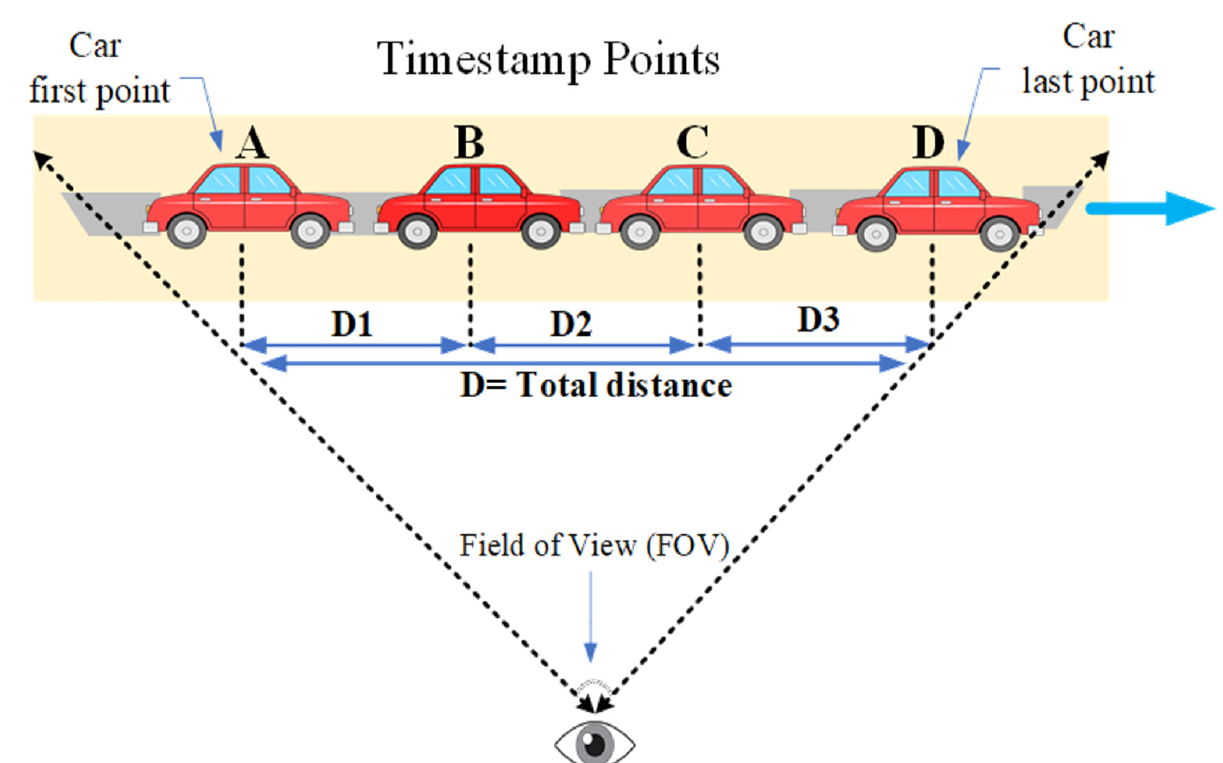
Figure 5. Schematic view of the VASCAR approach in different location of A to D.